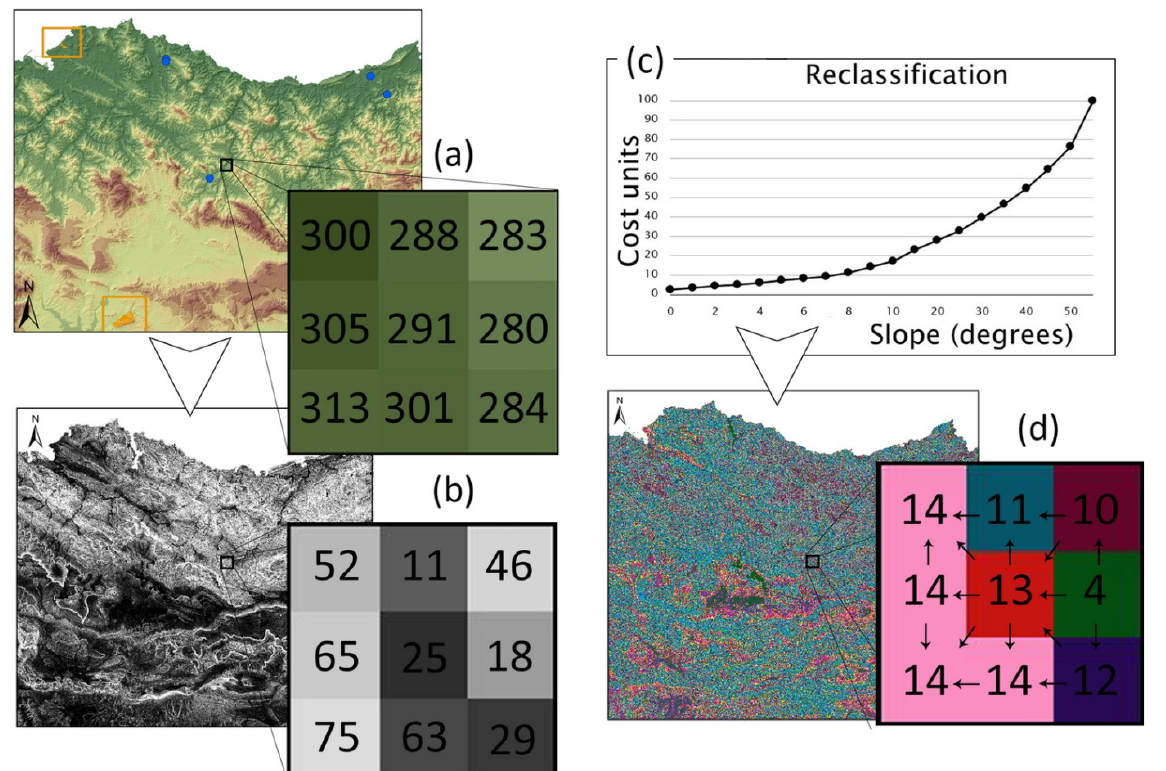
Figure 2. Methodological diagram showing the first four steps of the procedure for getting cost maps: a) digital elevation model showing the location of the archaeological sites and flint outcrops, with detail of the elevation value of each pixel; b) slope map, with detail of the slope value of each pixel; c) reclassification curve; d) slope map reclassified according to the reclassification